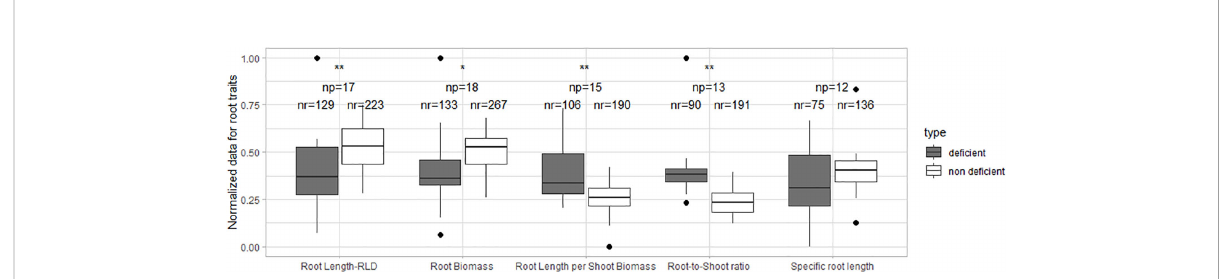
FIGURE 2 Boxplot of the normalized root data under N de fi ciency and N non-de fi ciency. A t-test was performed; * stands for signi fi cant differences at a 0.9 con fi dence level and ** at a 0.95 con fi dence level. np stands for the number of publications/studies considered in the calculation, and nr is the total number of observations within these publications